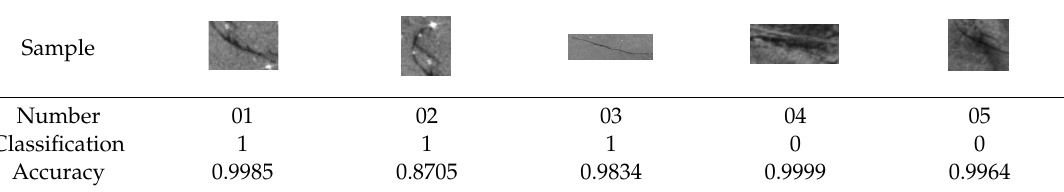
Figure 13. Typical SAR image containing oil spills: ( a ) Oil spills classified by AAMLP. The dark patches marked with magenta boxes are false alarms in a low wind speed zone; ( b ) oil spills classified by OSCNet. The false alarms in (a) have disappeared. Table 12. Some dark patches correctly classified by OSCNet.